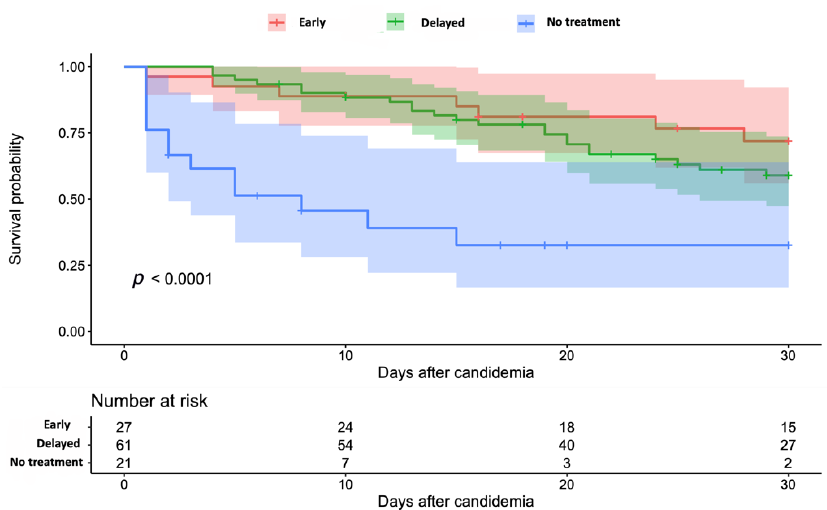
Figure 1. Survival analysis of patients with candidemia according to the time of start of treatment. Note: The coloured shadow shows the 95% confidence interval. Time was counted beginning the day the blood sample was taken.